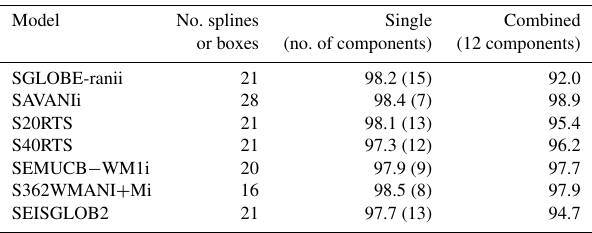
Table 2. Variance [%] obtained from the individual varimax analy- sis of each model. In parentheses, the number of components cap- turing more than 1% of the variance is shown. The last column provides the variance captured by 12 components for the combined analysis of the seven models, as discussed in Sect. 6. The second column provides the number of splines or boxes originally used in the models.